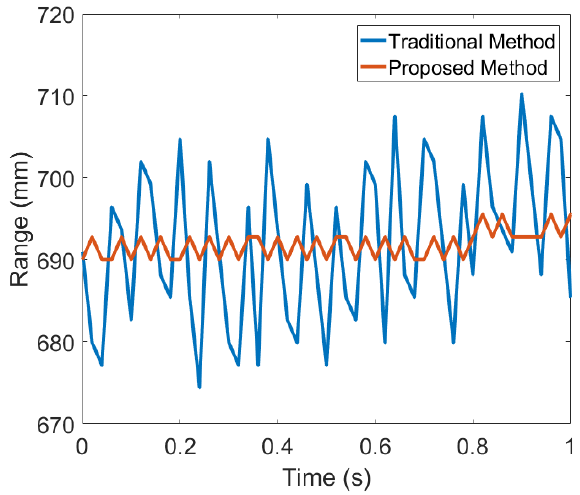
Figure 8. The static measurements obtained from the ultrasonic system using the classical and the proposed